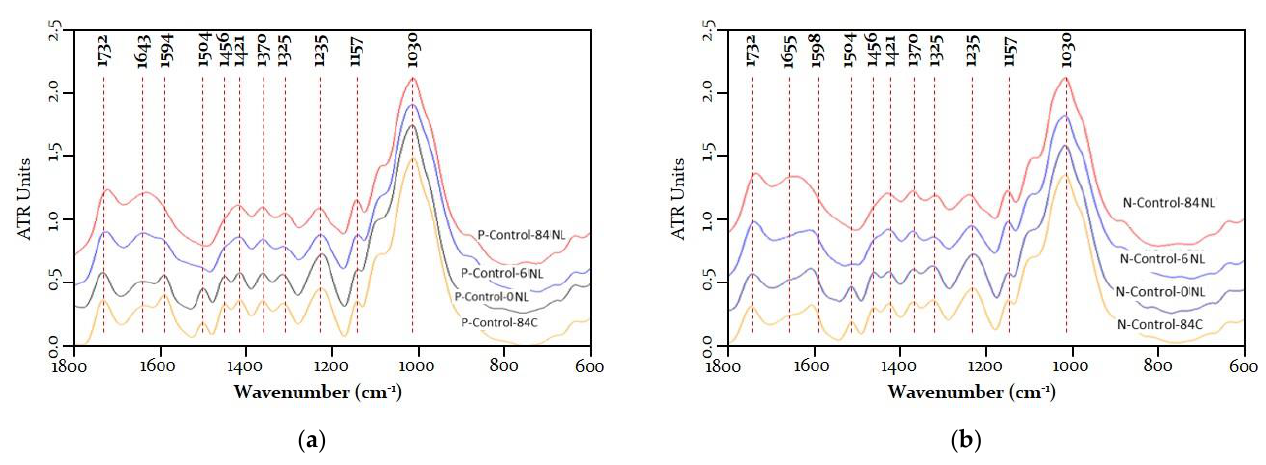
Figure 4. Comparative FTIR spectra (in the fingerprint region 2000 – 600 cm −1 ) of uncoated wood samples before (0NL) and after simulated natural ageing for 6 (6NL) and 84 months (exposed to light 84NL and covered areas 84C): ( a ). European Maple wood (P); ( b ). European Walnut wood (N).